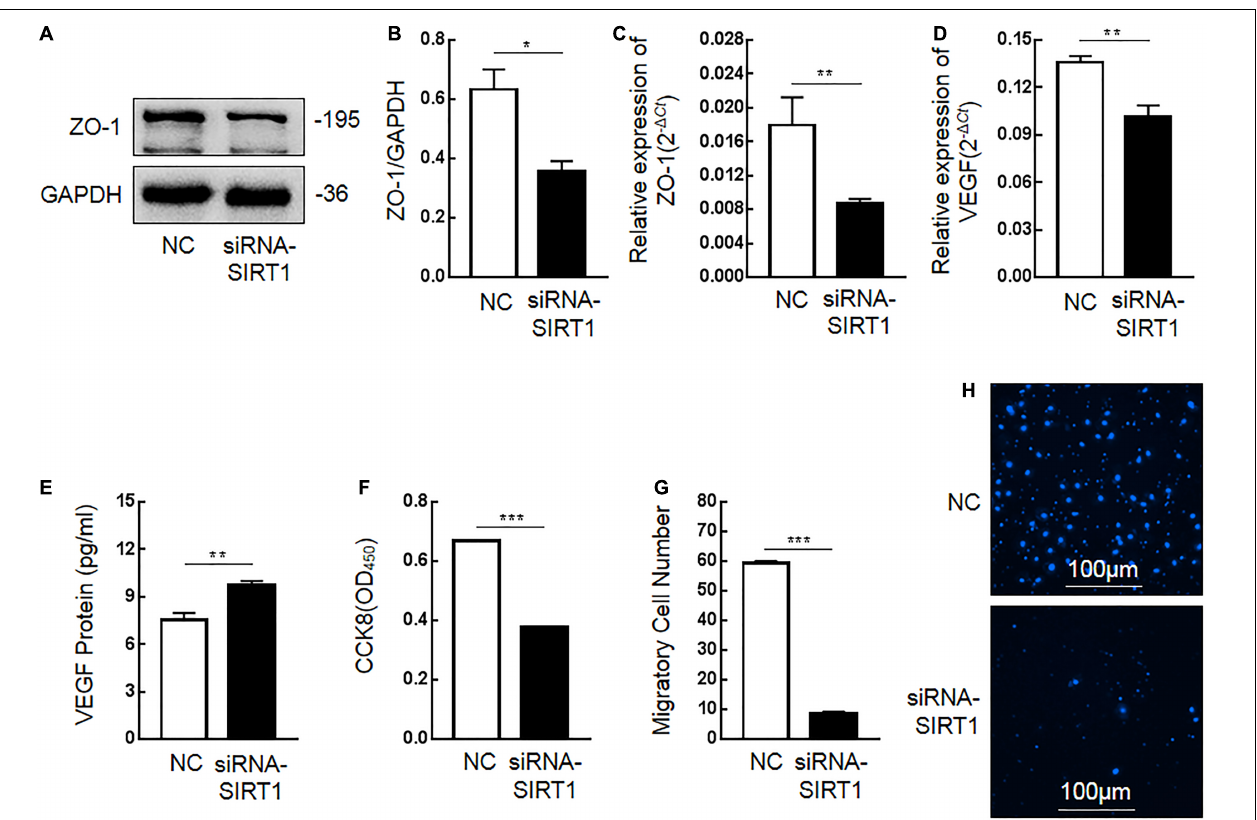
FIGURE 6 | The influence of Sirtuin1 or Silent mating–type information regulation 2 homolog-1 (SIRT1) on related indexes of intestinal mucosal barrier function. (A,B) After inhibiting the expression of SIRT1 in intestinal epithelial cells 6 (IEC6), the expression of tight junction protein-1 (ZO-1) protein decreased. (C) After inhibiting the expression of SIRT1 in IEC6 cells, the expression of ZO-1 mRNA decreased. (D) After inhibiting the expression of SIRT1 in IEC6 cells, the expression of vascular endothelial growth factor (VEGF) mRNA decreased. (E) After inhibiting the expression of SIRT1 in IEC6 cells, the expression of VEGF protein in the cells increased. (F) After inhibiting the expression of SIRT1 in IEC6 cells, the cell proliferation ability was significantly reduced. (G,H) After inhibiting the expression of SIRT1 in IEC6 cells, the cell migration ability was significantly reduced. (*Denotes the siRNA-SIRT1 groups compared with the control negative (NC) groups p < 0.05, ** denotes p < 0.01, *** denotes p < 0.001, n =